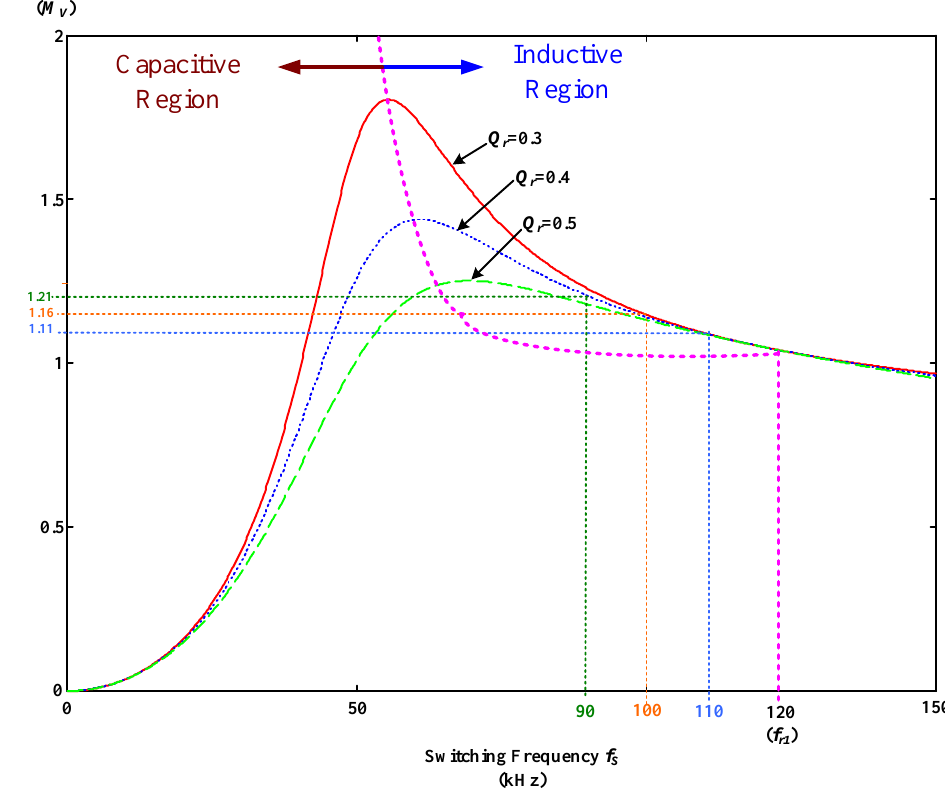
Figure 6. Relationship between the voltage gain M V of LLC resonant tank and the switching Figure6. Relationshipbetweenthevoltagegain M V ofLLCresonanttankandtheswitchingfrequency f S frequency f S .